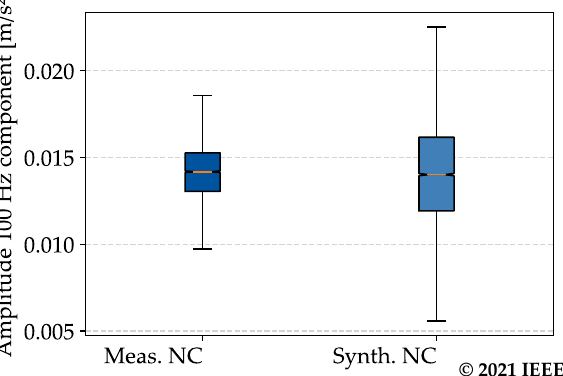
Figure 12. Box plots of the synthetic normal-condition data and normal-condition measurements [25].